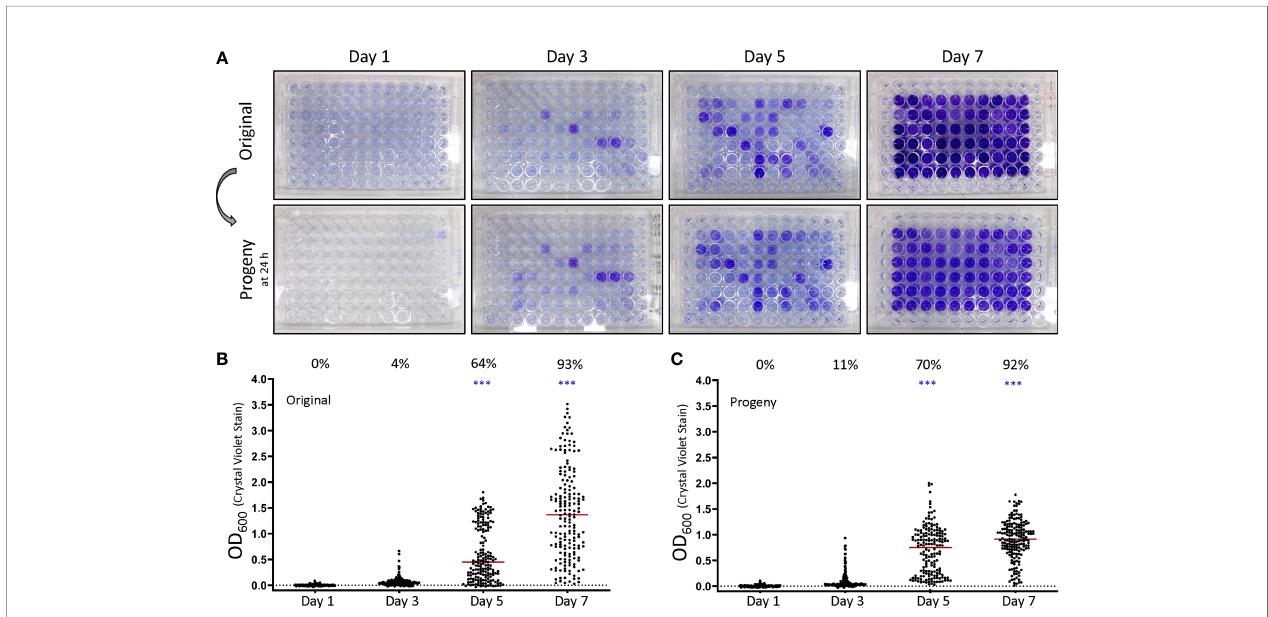
FIGURE 1 | F. tularensis subsp. holarctica LVS forms bio fi lm in a stochastic manner that is reproducible in progeny cells. (A) Bio fi lm formation in the original 96 well plates was assessed by crystal violet staining at the indicated time post inoculation. Prior to staining, the original plates were sub-cultured by replicate plating to create progeny plates. Progeny were assayed for bio fi lm development at 24 h post inoculation. Bio fi lm was quantitated by determining the OD 600 values after crystal violet staining for the (B) original plates and (C) progeny plates. Each point graphed represents an individual well in an experiment. The percent displayed above the graph for each day indicates the percent of bio fi lm positive wells as described in the materials and methods. The red bar indicates the median value after at least 3 independent experiments. To assess stochastic bio fi lm formation the log transformed OD 600 was analyzed by repeated measures linear mixed effects model. *** P <